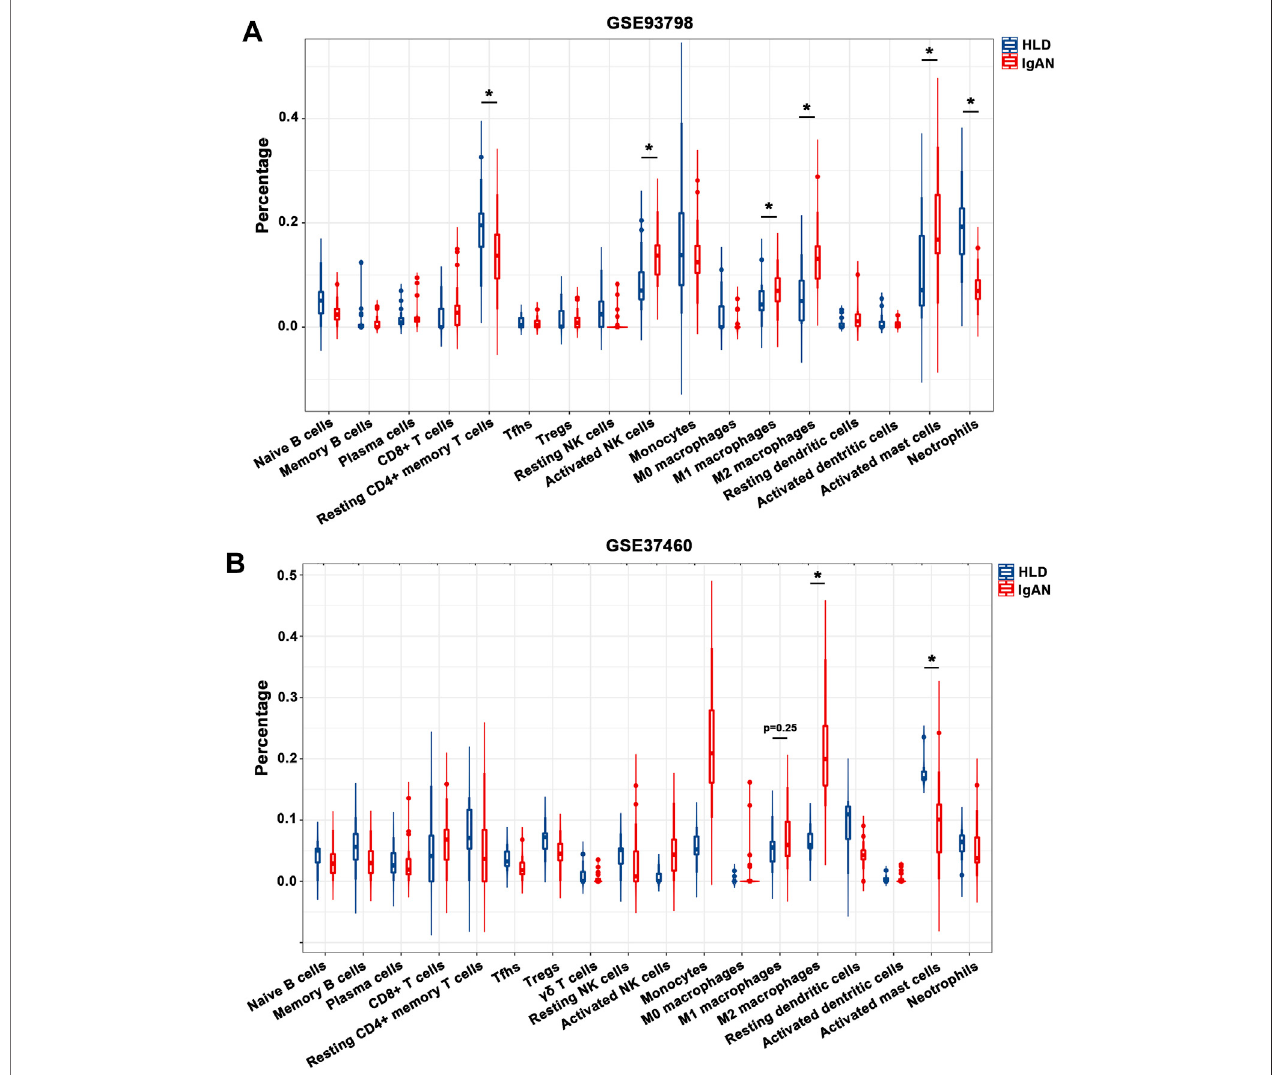
FIGURE 4 | Composition of in fi ltrating immune cell subpopulations in kidney tissues from IgAN patients. (A) Violin diagram of the proportion of immune cells in GSE93798. (B) Violin diagram of the proportion of immune cells in GSE37460. HLD, healthy living donor; IgAN, IgA nephropathy.